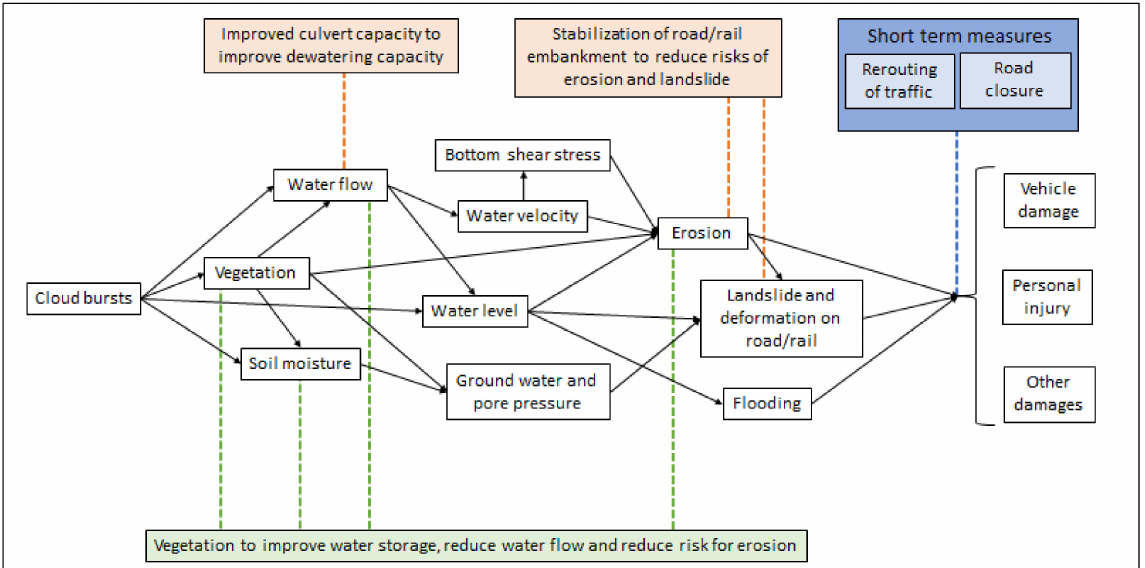
Figure 1. Potential impacts of a cloudburst, and examples of preventive (long-term, brown and green text boxes) and more acute (short term, blue text boxes) measures and where they will impact the cause-effect